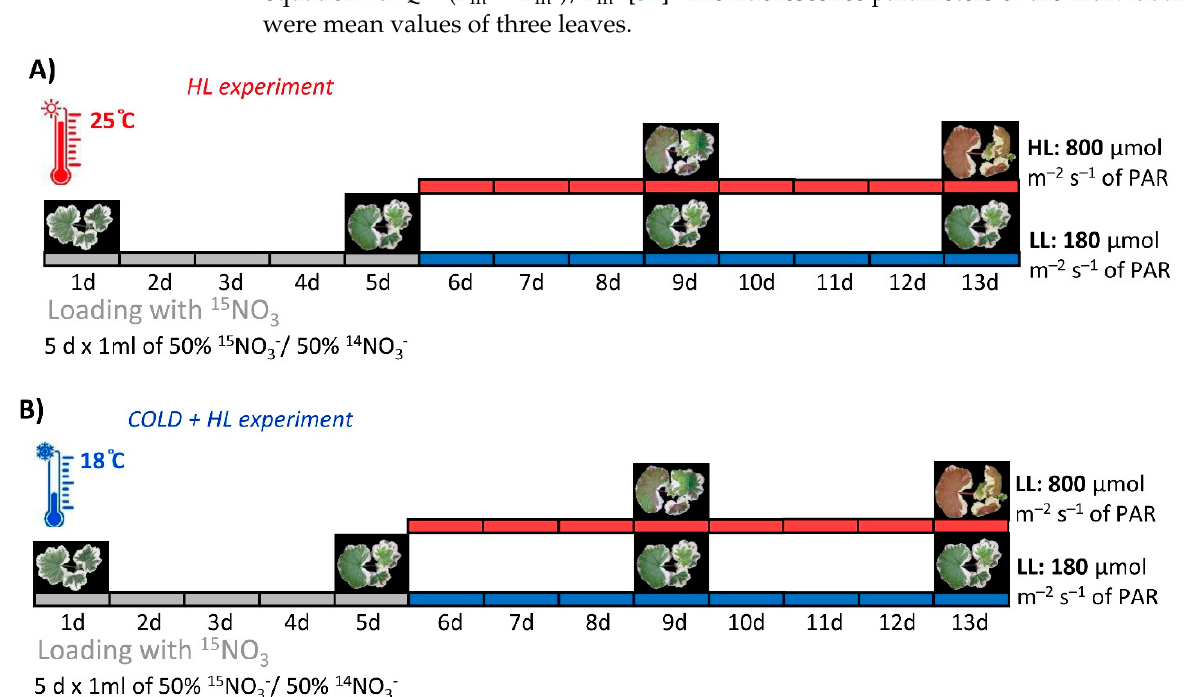
Figure 17. Schematic diagram of the experimental setup of the ( A ) HL experiment and ( B ) Cold + HL experiment. The photos of the plants represent the harvest times.